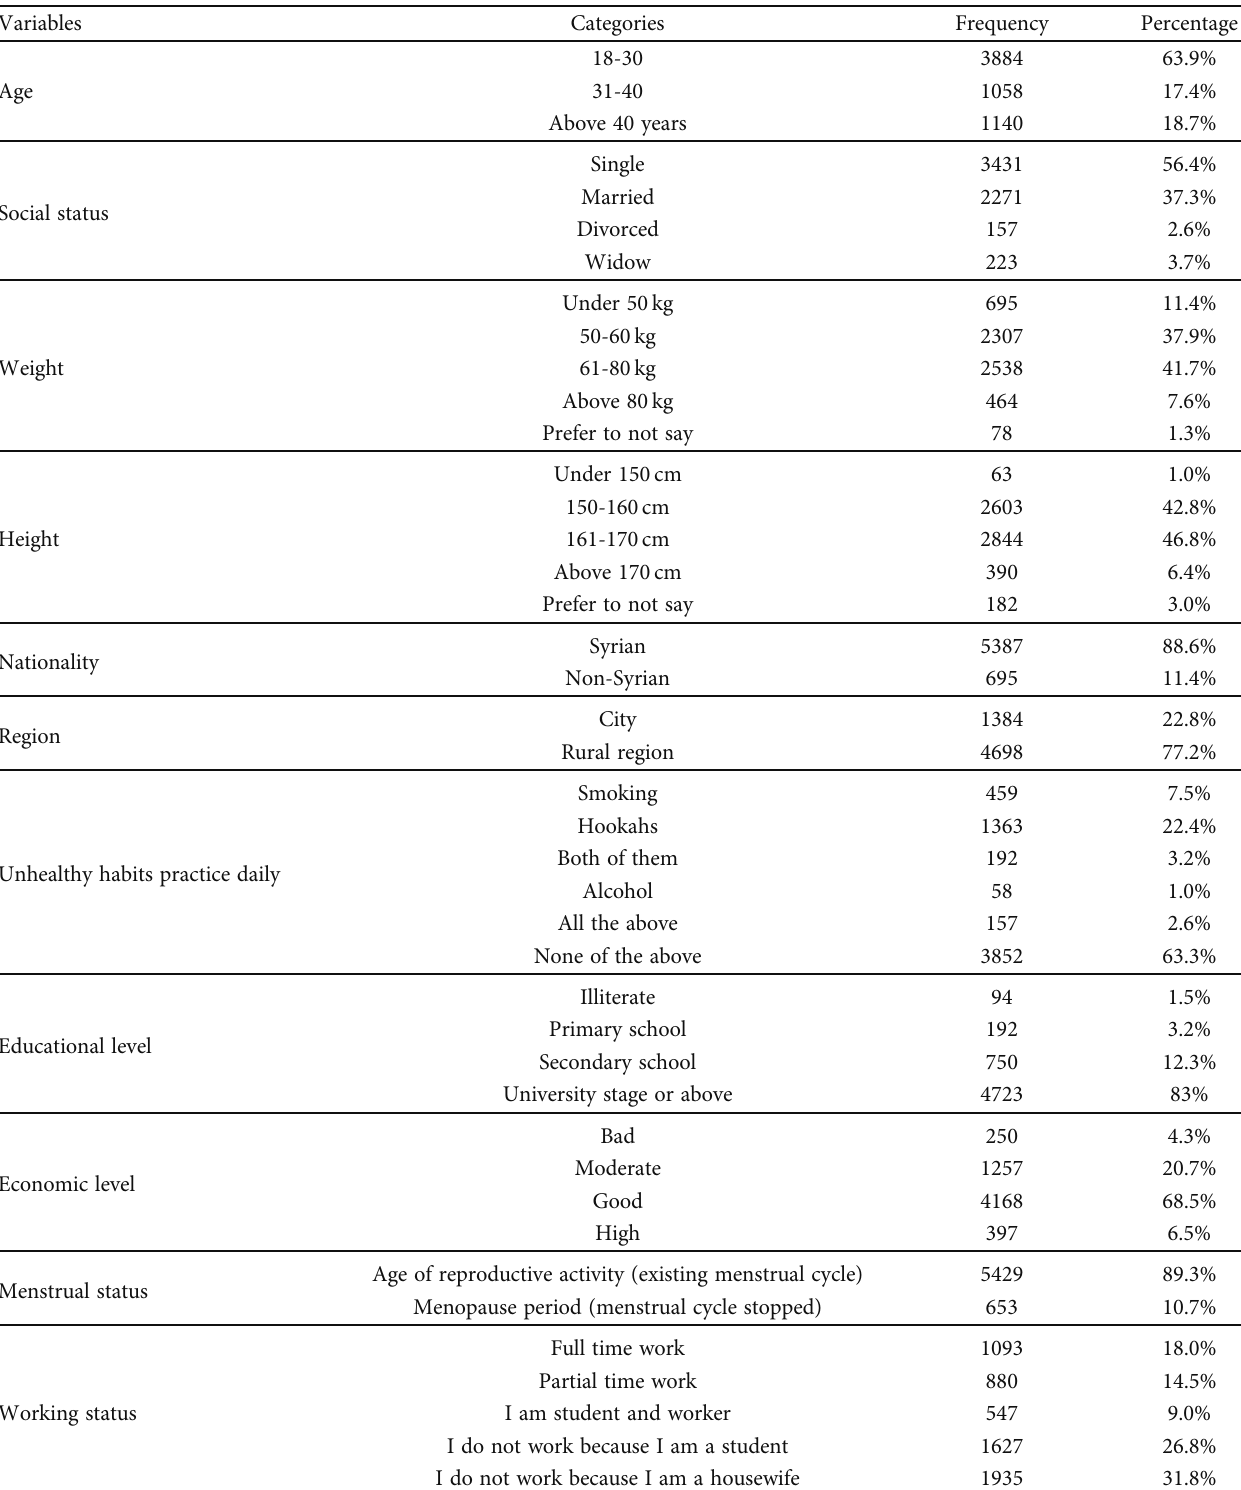
Table 1: Demographic variables of the study